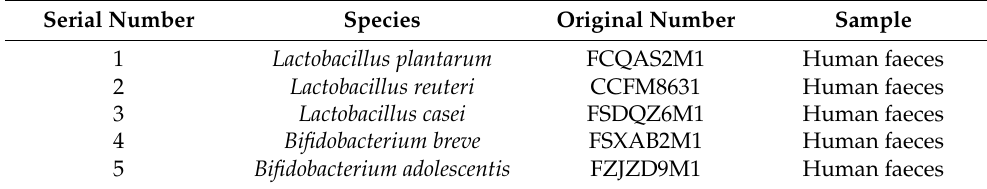
Table 1. Lactobacillus and Bifidobacteria used in this